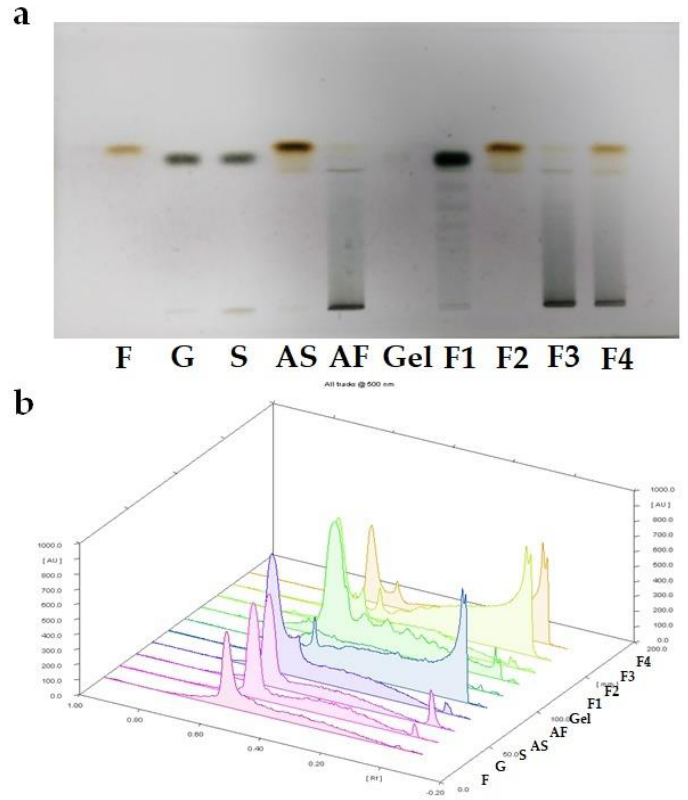
Figure 2. ( a ) HP-TLC silica gel plates of gel formulations; ( b ) densitogram obtained from carbohy- drates standards and gel formulations: Fructose (F), glucose (G), sucrose (S), agave syrup (AS), agave fructan (AF), gelatine (Gel), and gel formulations: F1 (control formulation), F2 (100% agave syrup), F3 (100% agave fructan), and F4 (50% agave syrup and 50% agave fructan). Sucrose (S), fructose (F), and agave syrup (AS) showed similar retention factors (Rf). In contrast, the agave fructan (AF) displayed two different spots; a light brown